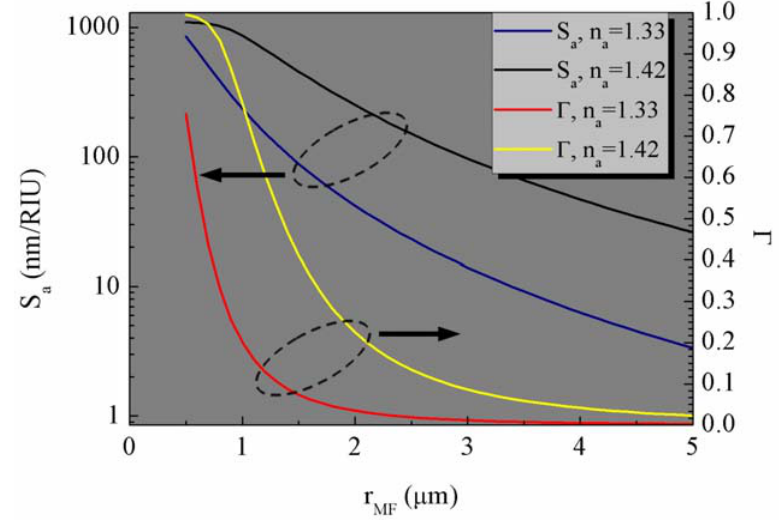
(blue and black line) and power fraction propagating in the Figure 6. Sensitivity S a surrounding medium Γ (red and yellow line) for different MF radii r is chosen to be at 1.33 and 1.42. Only the fundamental mode Λ is set at 550 nm and n a is